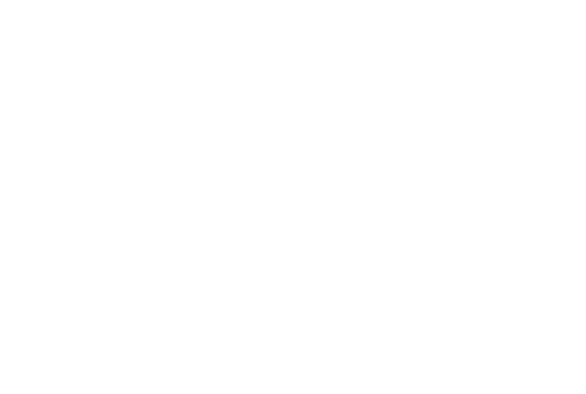
( c ) Figure 13. Winding configurations of two-phases open-circuited under three fault cases. ( a ) Case I; ( b ) Case II; ( c ) Case III In case I, the two groups are phase B1, C1 and phase B2, C2, respectively. The regu- lated current and total magnetomotive force are given as Equations (14) and (15), respec- tively. And the phasor diagram of the regulated current under Case I is given in the Figure 14 in addition.